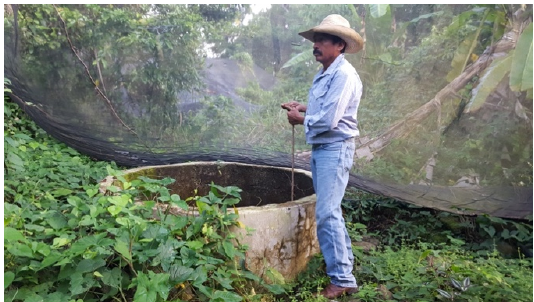
Figure 5. Sample Point 9 well.